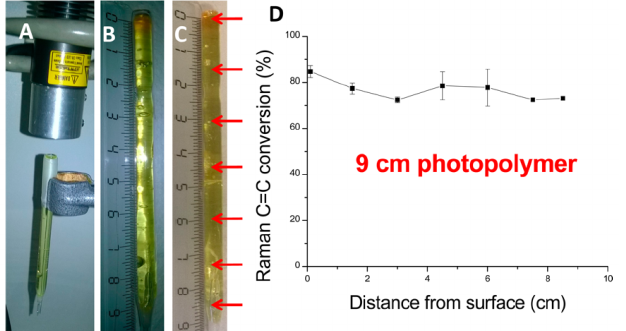
Figure 17. ( A ) Experimental set-up used to examine the polymerization in shadowed areas. ( B ) The Pasteur pipette with the resin before irradiation. ( C ) The resulting polymer obtained after polymerization. ( D ) Final monomer conversion vs. the distance of the irradiation point. Reproduced with permission from the authors of [28]. Copyright 2017 American Chemical Society.